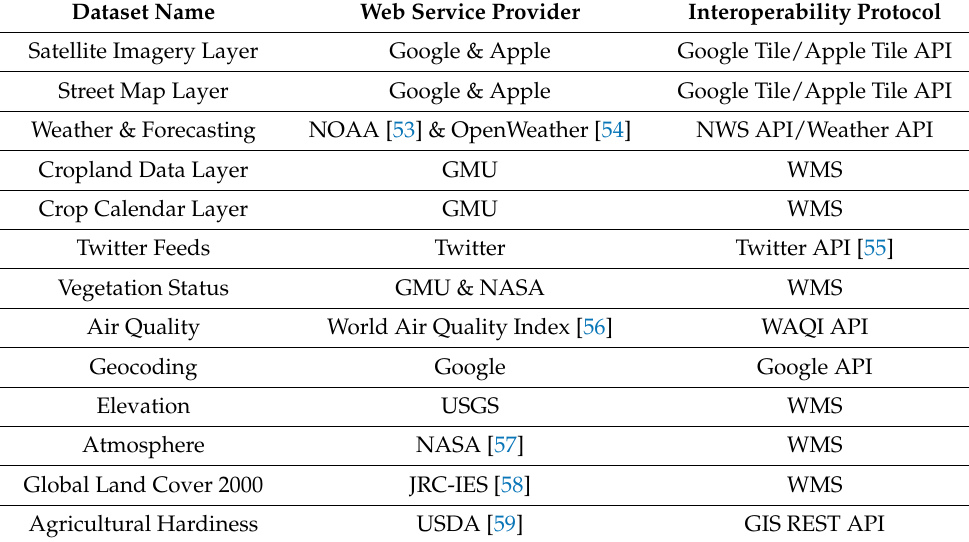
Table 1. Data list and web service sources used in